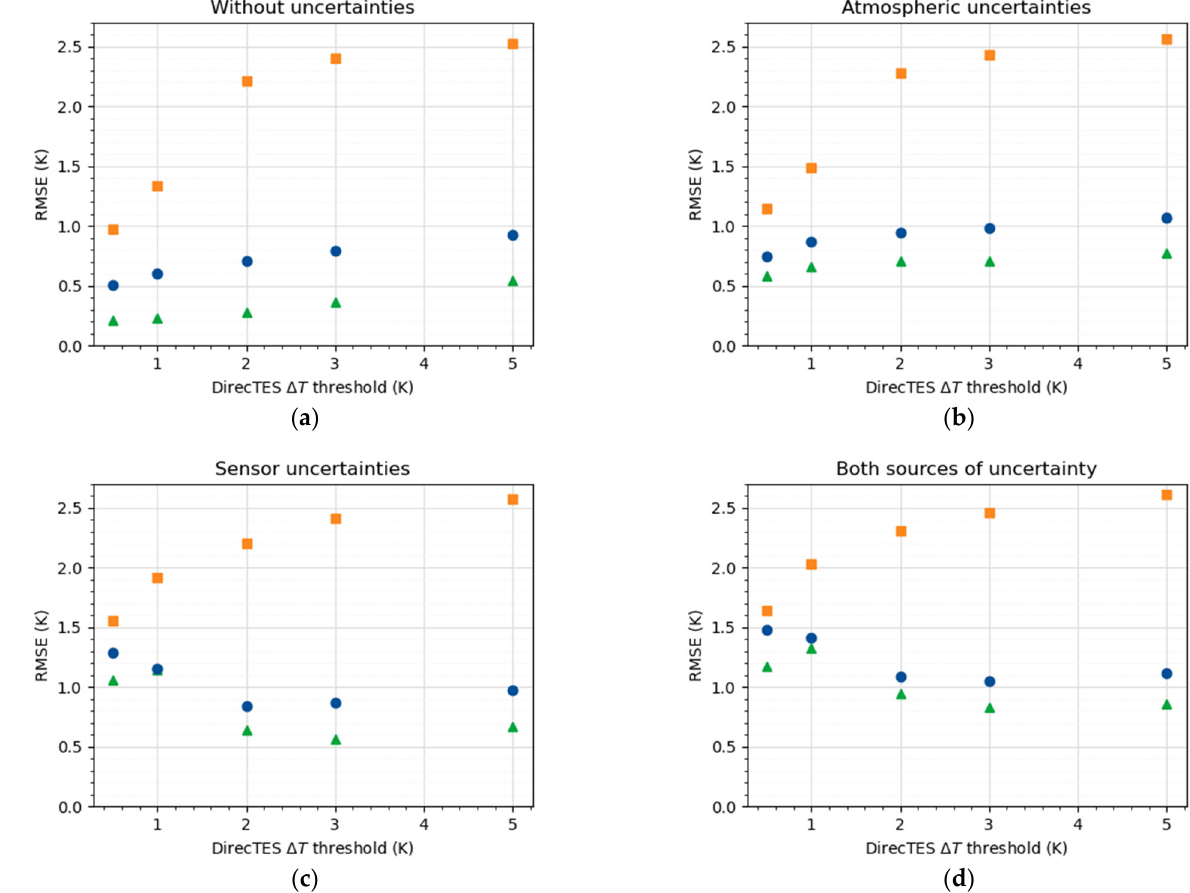
Figure 10. RMSE in DirecTES retrieved temperature as a function of DirecTES ∆ T threshold ( ∆ T thresh ) , for each kind of material (green triangle: vegetation; blue dot: water; orange square: urban materials) in the presence of no uncertainty ( a ), atmospheric ( b ), sensor ( c ) and both sources of uncertainty ( d ).